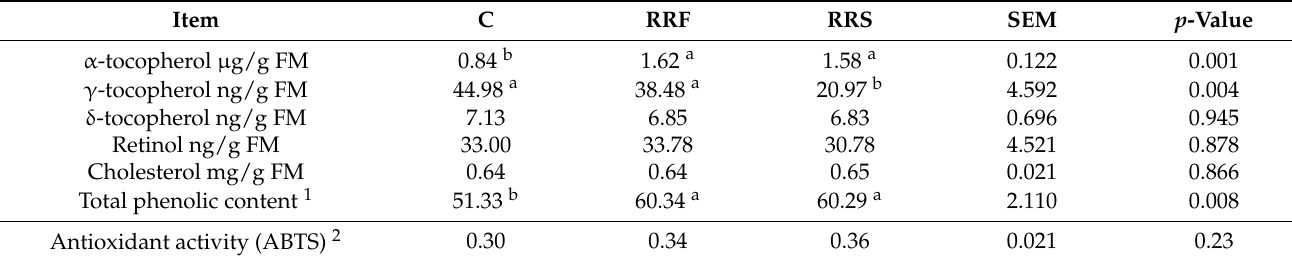
Table 2. Tocopherols, retinol, cholesterol, antioxidant activity, and phenolic compounds of meat.